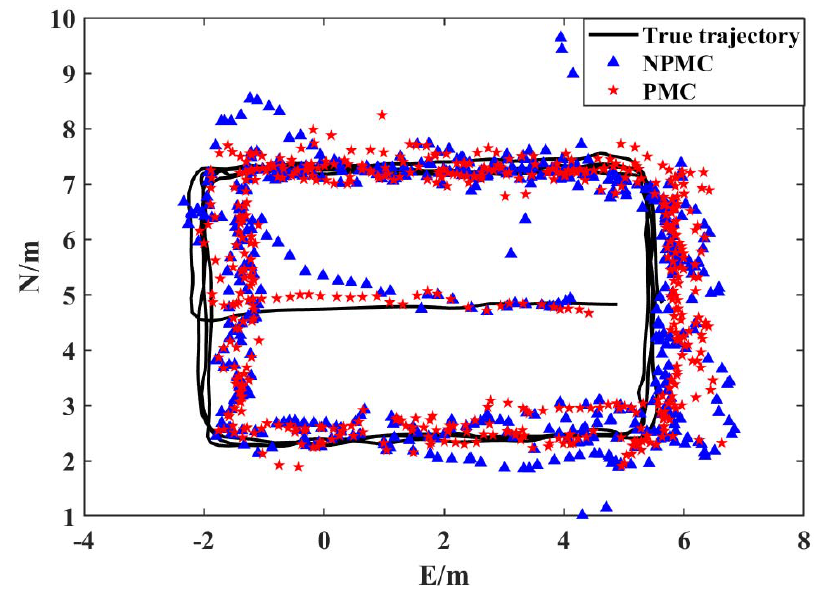
Figure 8. Influence of pedestrian motion characteristics constraint information on positioning results.